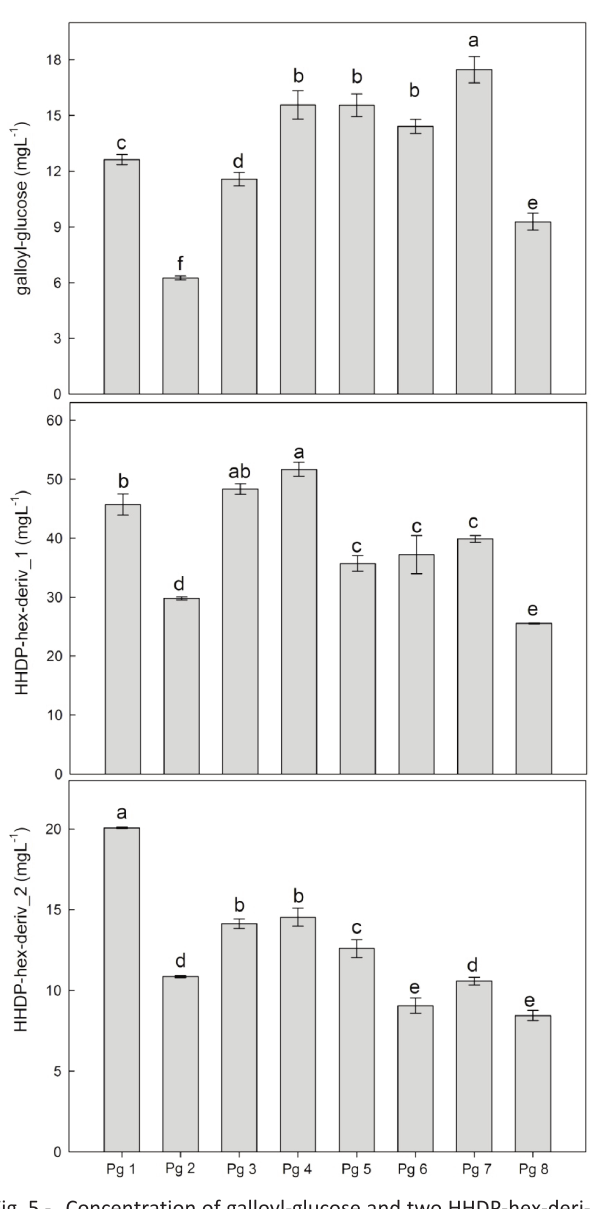
Fig. 5 ­ Concentration of galloyl­glucose and two HHDP­hex­deri­ vatives (HHDP­hex­deriv_1 and HHDP­hex­deriv_2) in the juices obtained from pomegranate fruits of different accessions. The bars indicate the standard deviation (n=3). Different lowercase letters indicate significant dif­ ferences according to Tukey’s test (p ≤